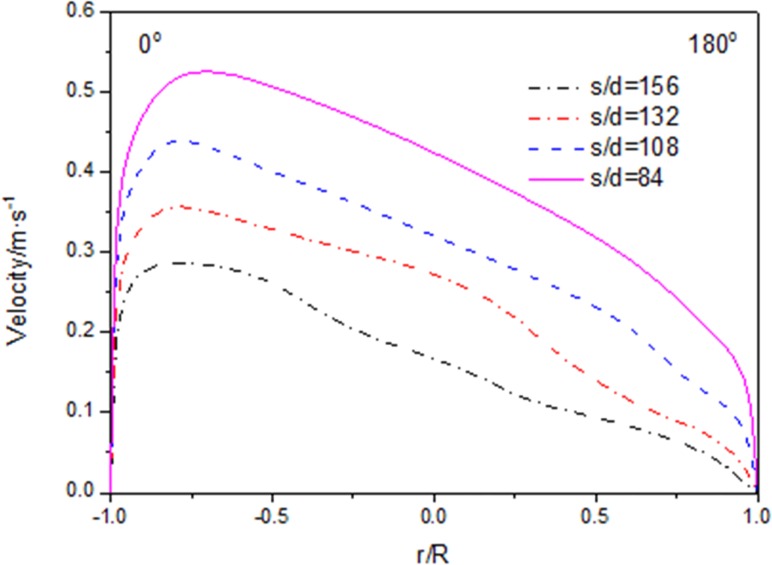
Radial distributions of velocity magnitude.